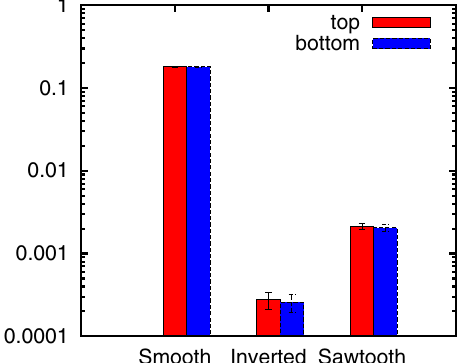
FIG. 6. Fraction of photons absorbed at the top and bottom of the vacuum chamber of the LHC, with a 95% confidence